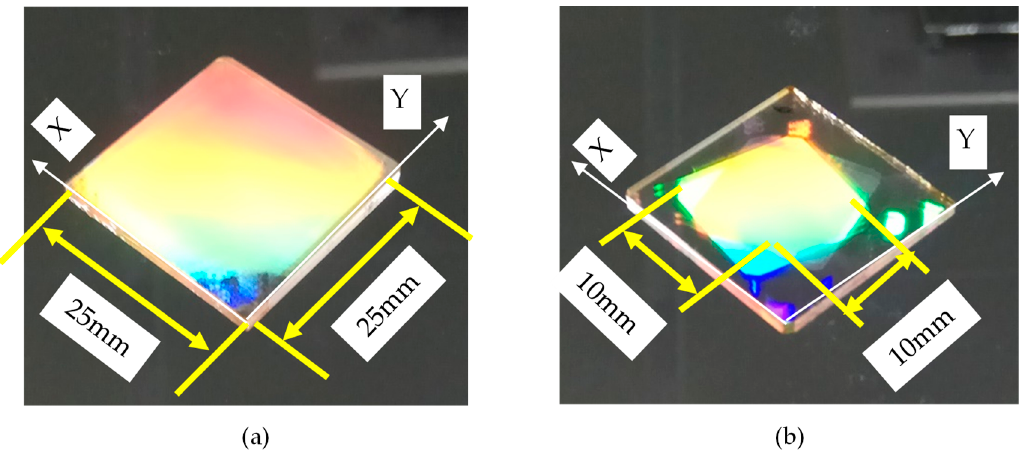
Figure 5. Photographs of the fabricated 2D gratings under the initial polarization status of ( a ) (s, s, s) under conditions of exposure time 30 s, development time 8 s and ( b ) (s, − 33.5°, 33.5°) under exposure time 30 s, development time 8 s.